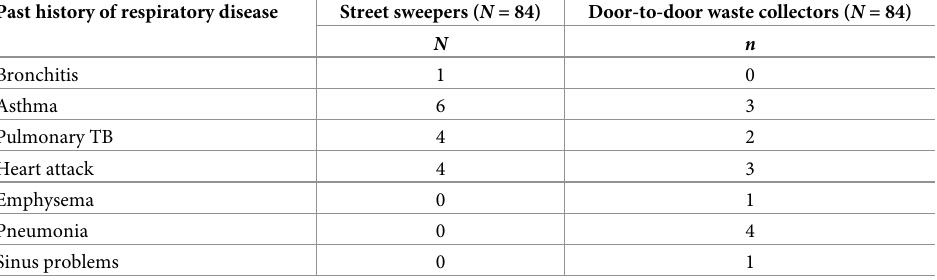
Table 4. History of past respiratory disease among street sweepers and door-to-door waste collectors in Dessie City, March to May 2018. Past history of respiratory disease Street sweepers ( N = 84) Door-to-door waste collectors ( N = 84) N n Bronchitis